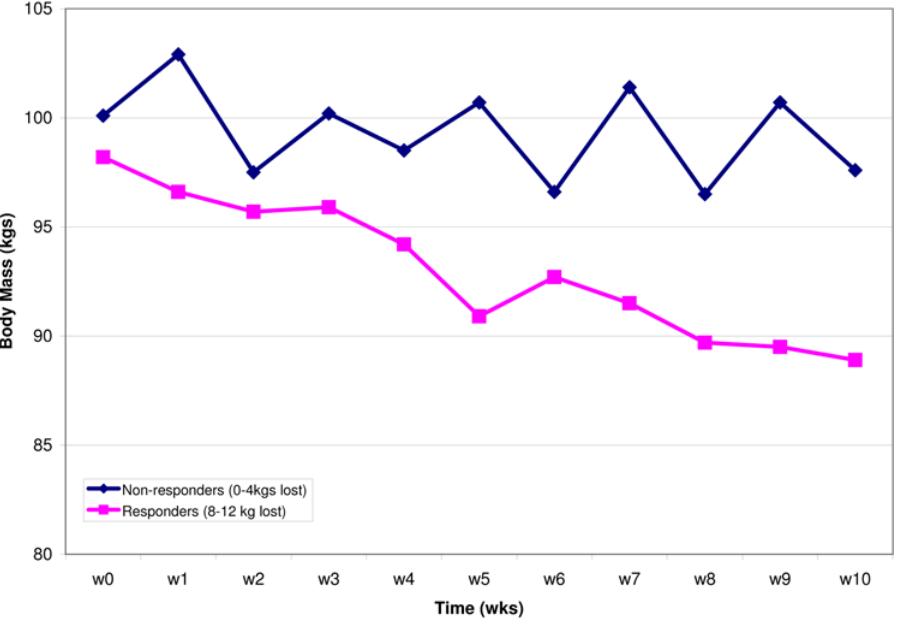
Figure 1. Weight loss curves during the 10 week hypocaloric diet. The two groups were defined as responders (i.e. subjects losing between 8– 12 kgs) and non-responders (i.e. subjects losing less than 4 kgs). Weight was measured in at least 43 subjects at each weekly time point. Error bars represent the 95% confidence intervals (equal to 1.96 * standard deviation). doi:10.1371/journal.pone.0001344.g001 instructions (Promega, Charbonnieres-les-Bains, France). Sybr H green primers were designed and validated for target specificity and amplification efficiency. Primer sequences for Ptgds, Fmod,